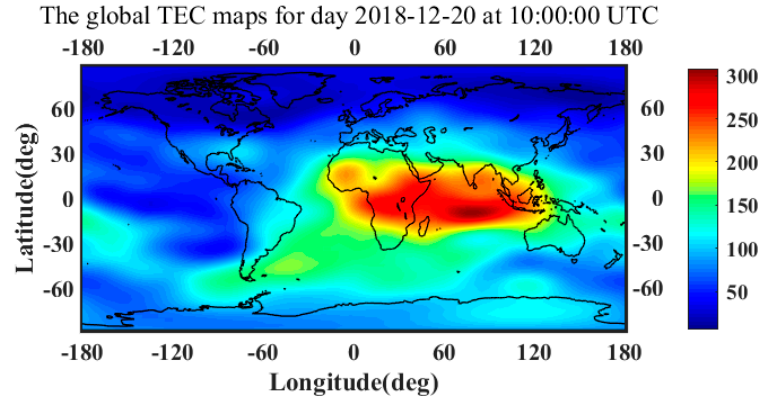
Figure 2. The global TEC maps for day 20 December 2018 at 10:00:00 UTC.